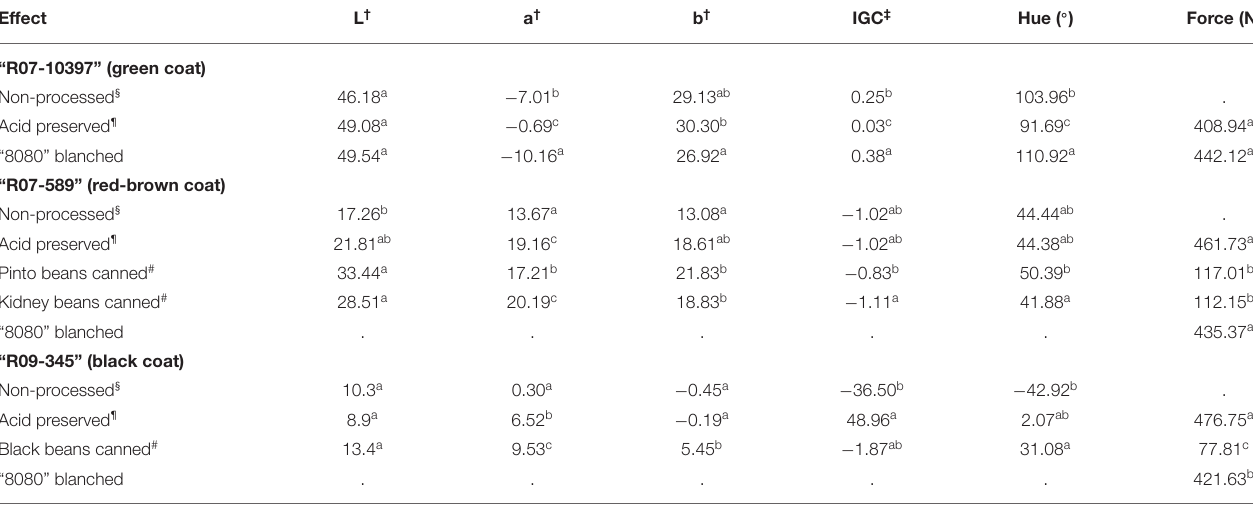
TABLE 4 | Color and texture (force) values of three edamame varieties with colored seed coats harvested at the mature (R8) growth stage.